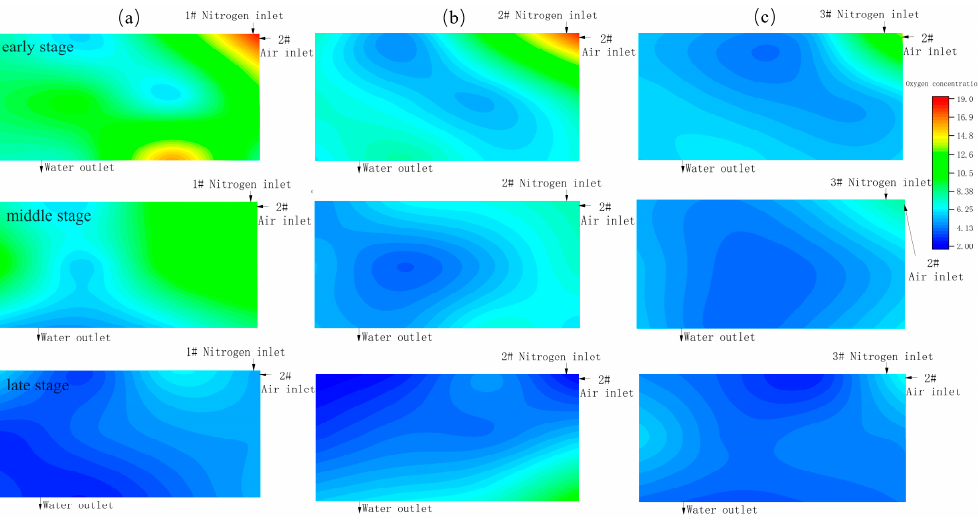
Figure 8. Change characteristics of SC hazardous area in the goaf under different nitrogen injection positions. ( a ) 1# nitrogen injection, ( b ) 2# nitrogen injection, ( c ) 3# nitrogen injection.